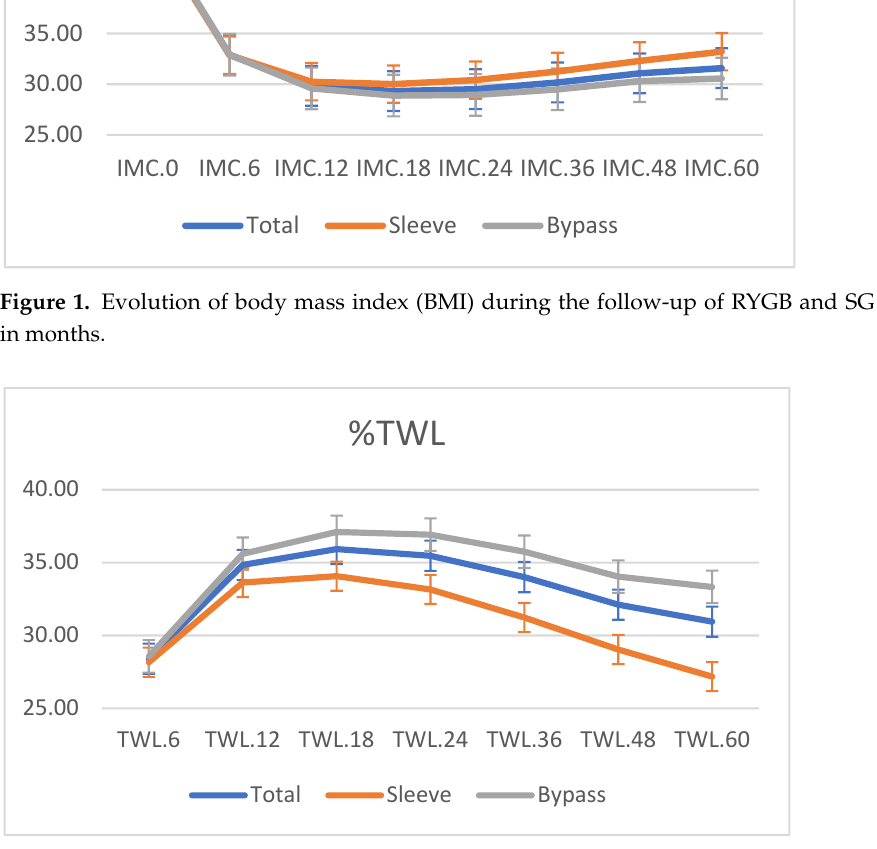
Figure 2. Evolution of % total weight loss (TWL) during the follow-up of RYGB and SG expressed in months.